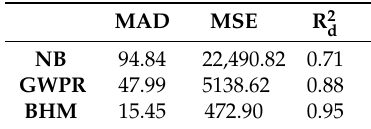
Table 3. Comparison between Models.